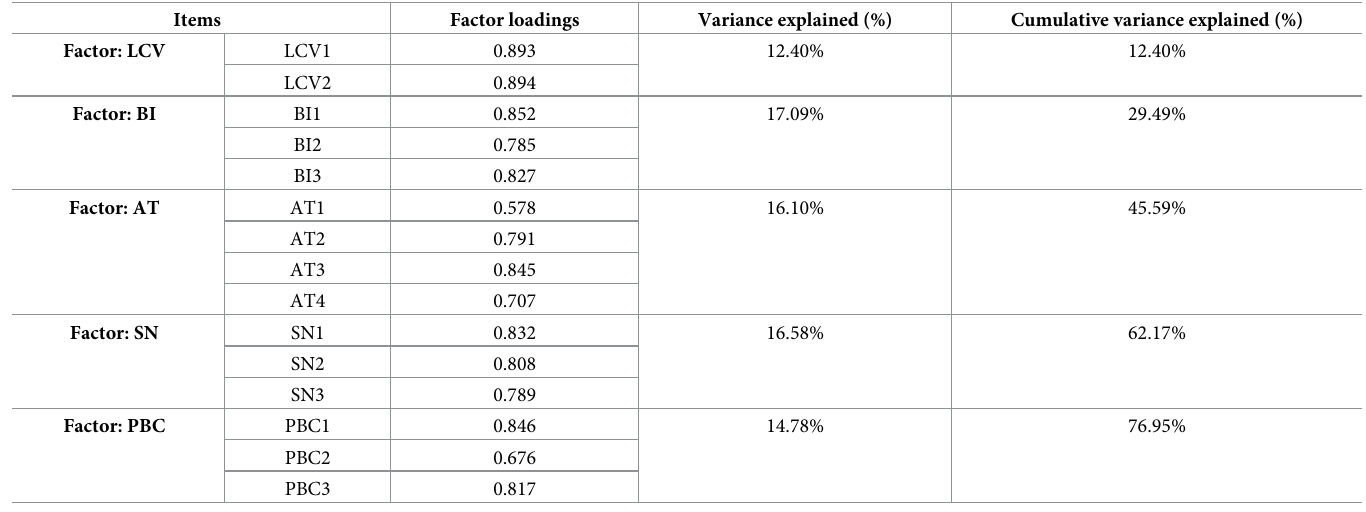
Table 7. Results of EFA ( N =